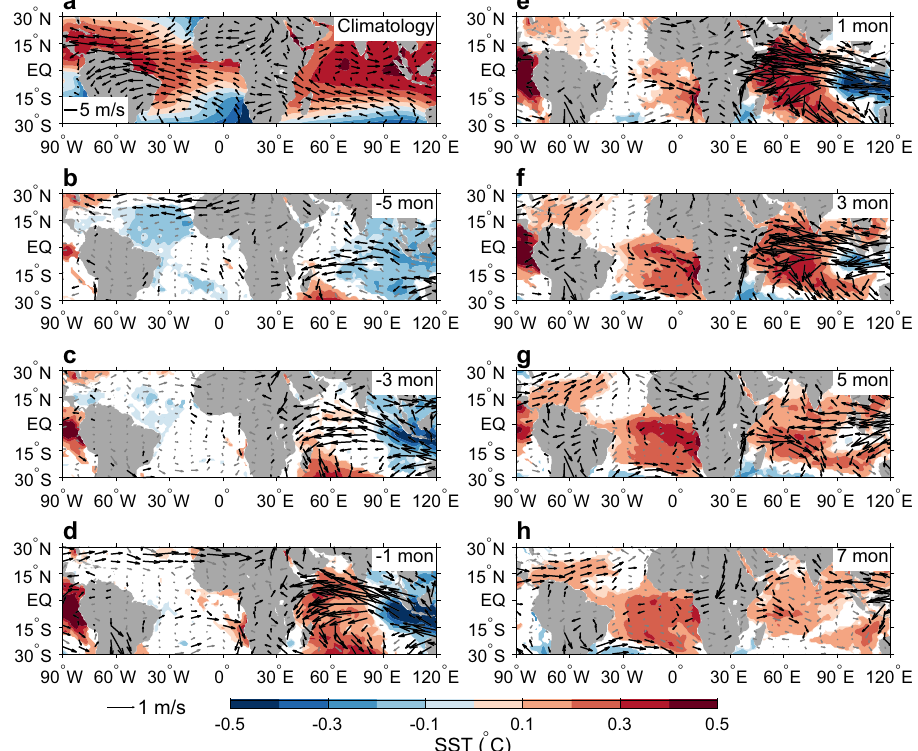
Fig. 1 Impact of positive IOD on Atlantic Niño. a Annual mean climatology of sea surface temperature (SST) (°C) and 850hPa wind (m s − 1 ). b – h Lead-lag regression of monthly SST anomalies (SSTA; shading; °C °C − 1 ) from the Hadley Centre Sea Ice and SST (HadISST) and 850 hPa wind anomalies (vector; m s − 1 °C − 1 ) from the European Centre for Medium-Range Weather Forecasts (ECMWF) twentieth-century reanalysis (ERA-20C) on monthly Dipole Mode Index (DMI), which represents the Indian Ocean Dipole (IOD) mode. b – h Results for — 5 to 7 months leading time, with negative representing months prior to IOD peak and positive for after IOD peak. Shading and black vectors represent anomalies that are statistically signi fi cant at the 90% con fi dence